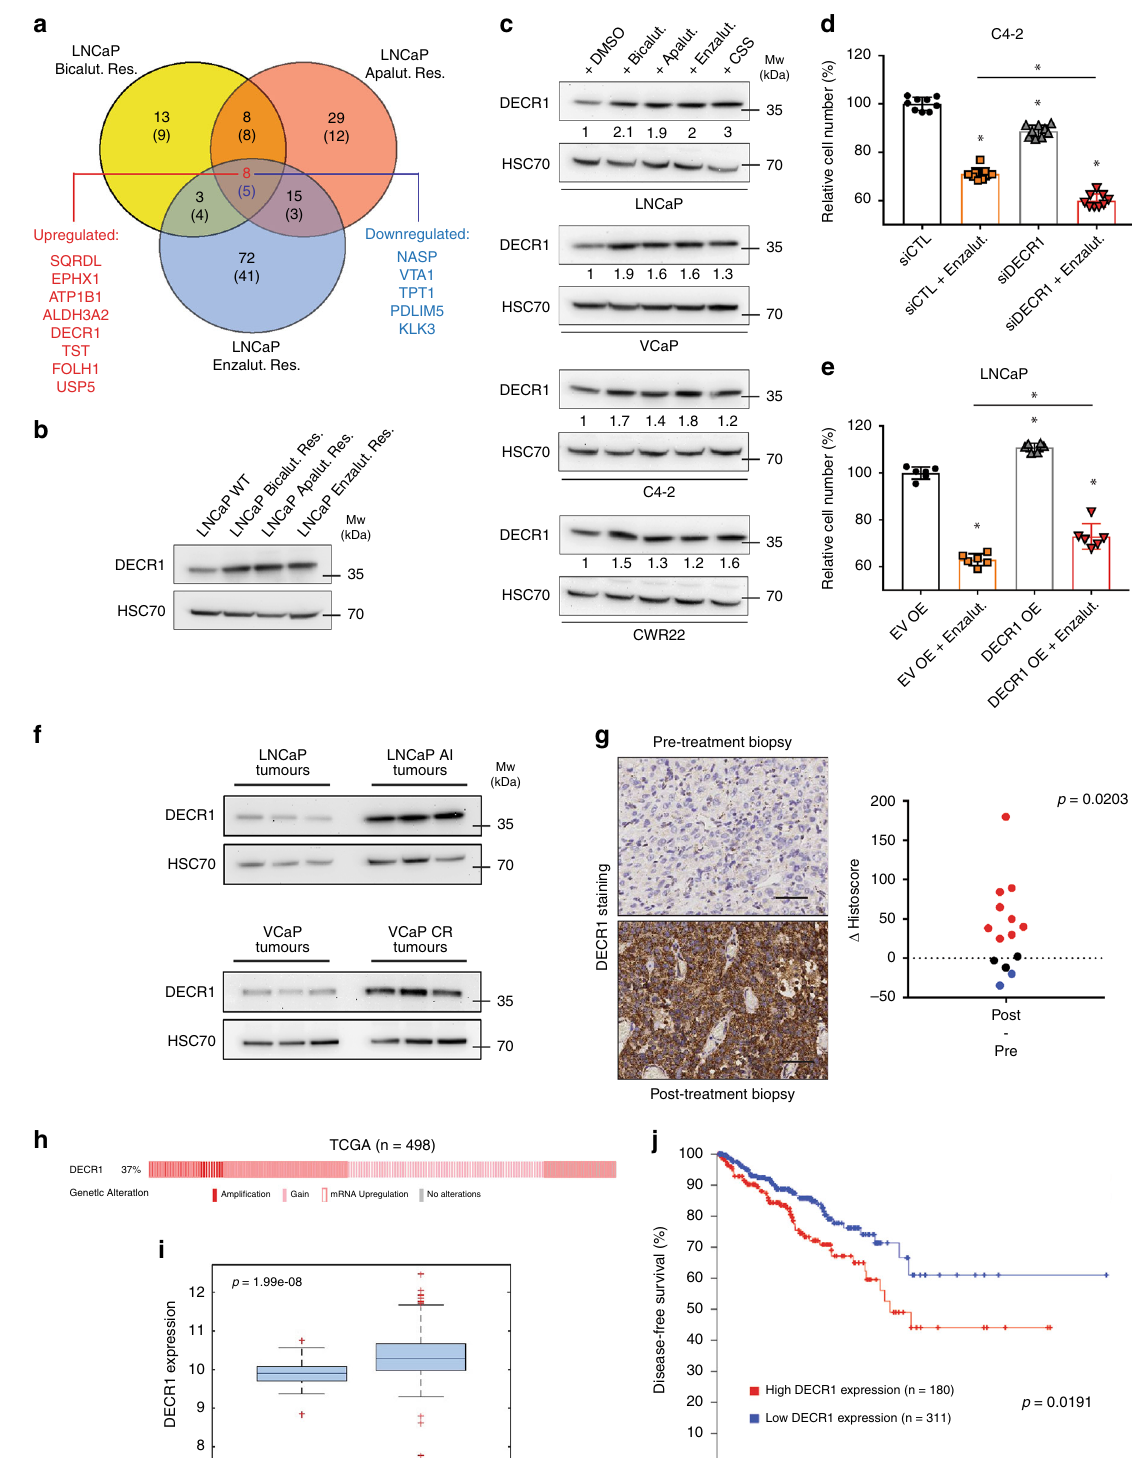
KO cells presented higher levels of polyunsaturated fatty acids (PUFAs), especially arachidonic acid (AA) and docosahexaenoic acid (DHA), while they showed decreased levels of the monounsaturated fatty acids (MUFAs) palmitoleic acid (PalA) and sapienate (SA) (Fig. 6e). While MUFAs have been shown to protect against oxidative stress 30 , cellular accumulation of PUFAs can result in lipid peroxidation and induction of ferroptosis 31 .